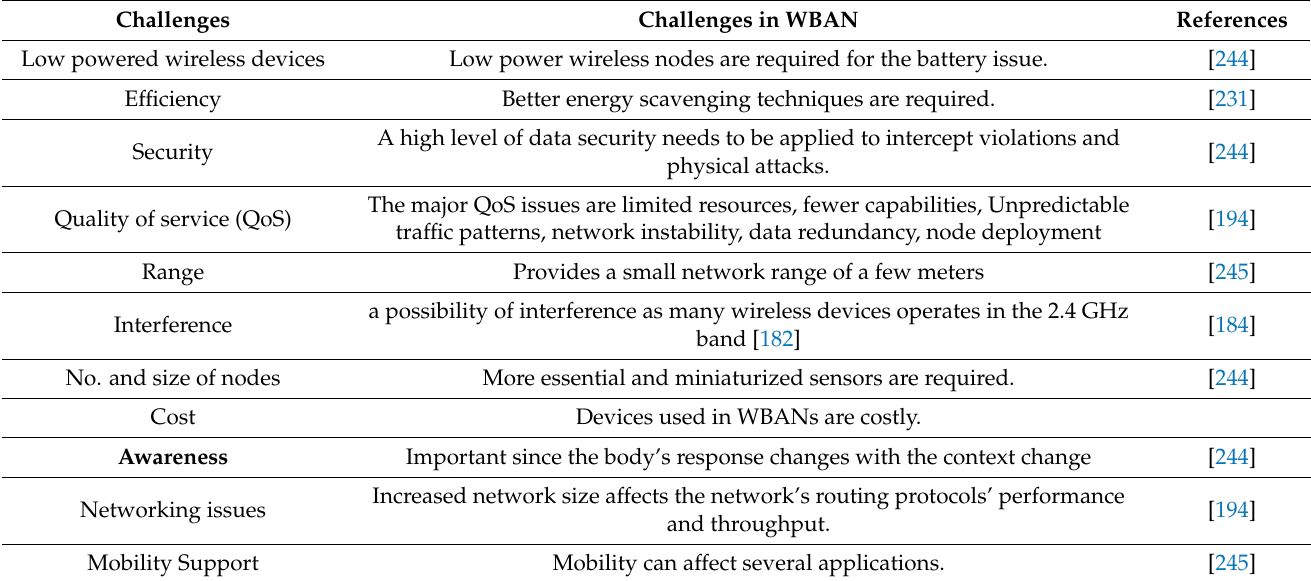
Table 11. Challenges of